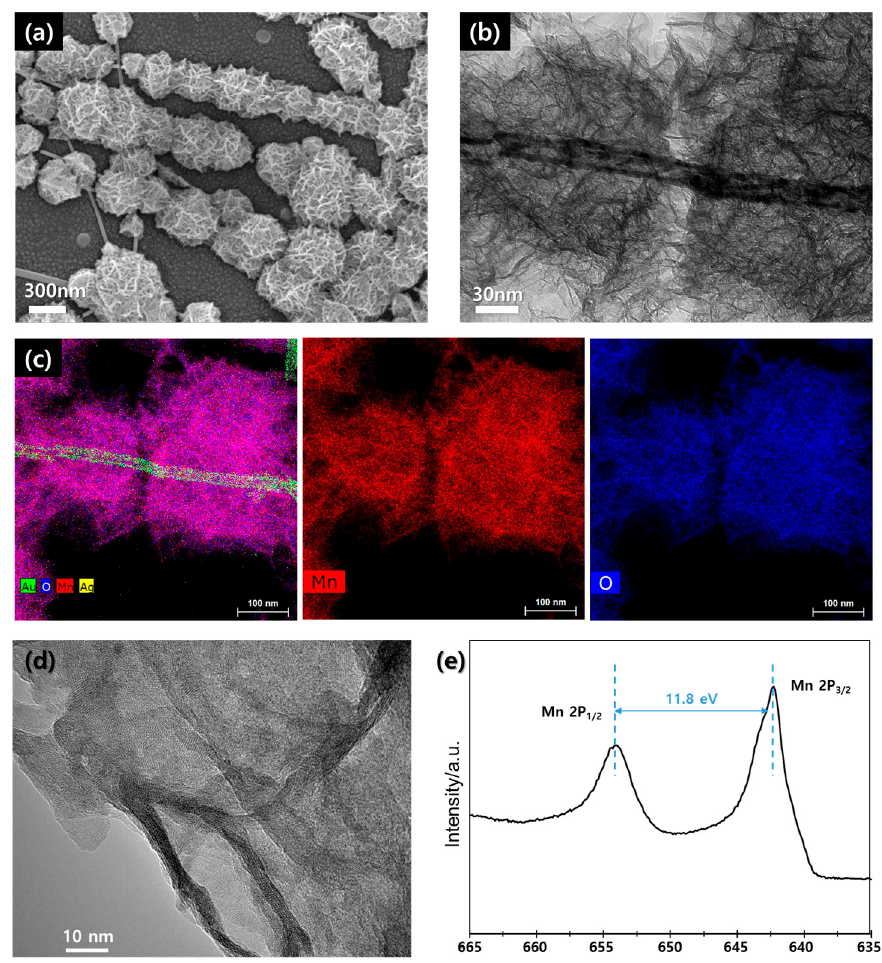
Figure 4. ( a ) SEM image. ( b ) TEM image. ( c ) TEM-EDX mapping image. ( d ) HRTEM image. ( e ) XPS analysis result of the electro-plated material on the AACS NW.